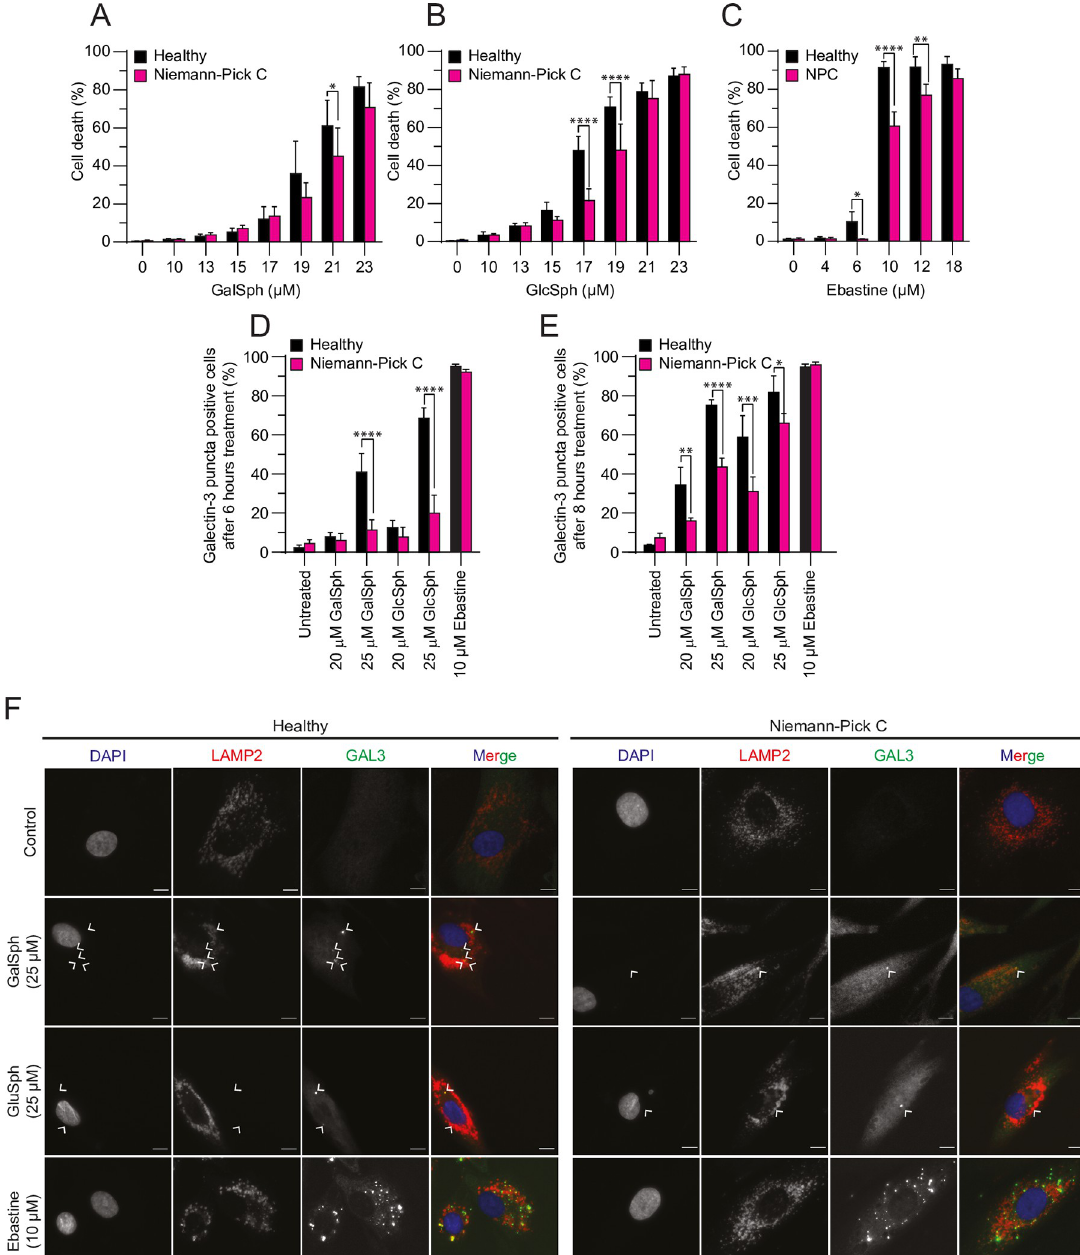
Fig 7. Niemann-Pick type C fibroblasts are resistant against GalSph- and GlcSph-induced cell death. (A-C) Death of fibroblasts from healthy controls or patients with Niemann-Pick type C disease (NPC) treated with indicated concentrations of GalSph (A), GlcSph (B), or ebastine (C) for 48 hours was determined as in Fig 1A. (D-E) Percentage of galectin-3 puncta positive fibroblasts from healthy controls or from patients with Niemann-Pick type C disease after 6 hours (D) or 8 hours (E) of indicated treatments was visualized by immunocytochemistry. A minimum of hundred randomly chosen cells was analyzed per sample. (F) Representative images of fibroblasts from healthy controls or from patients with Niemann-Pick type C disease treated with indicated concentration of GalSph, or GlcSph, or ebastine for 6 hours were acquired using the ImageXpress ( DAPI , Cy5 and FITC channels). Scale bars, 10 μ m. Error bars, SD of three independent experiments. � , P < 0.05; �� , P < 0.01; ��� , P < 0.001; ���� , P < 0.0001 as analyzed by two-way ANOVA followed Sidak’s multiple comparisons